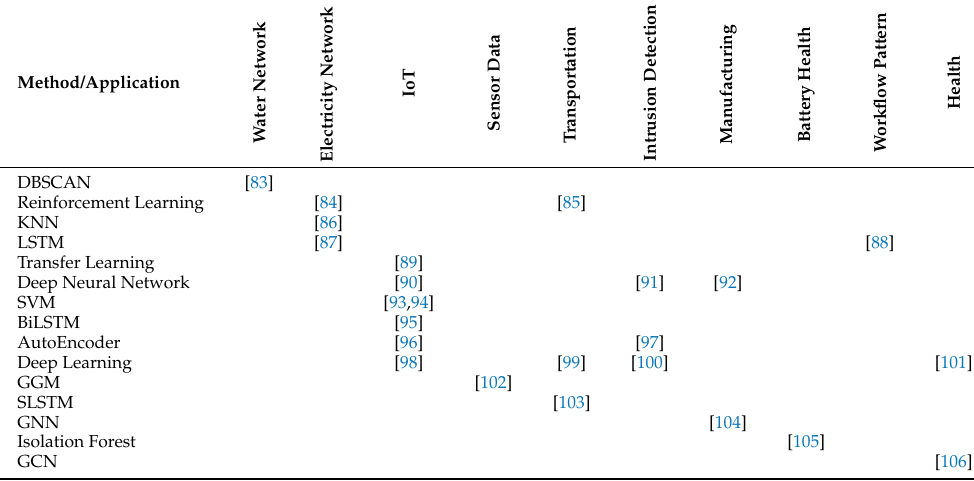
Table 6. Anomaly Detection in